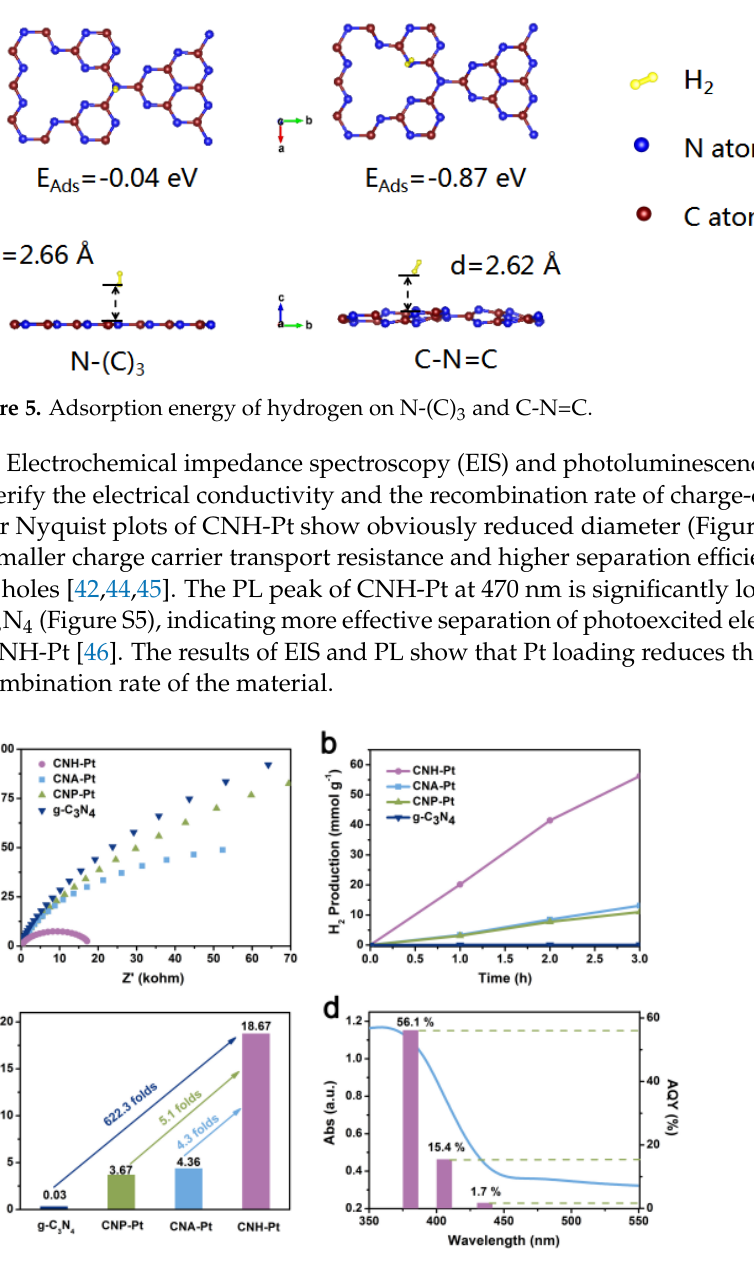
Figure 6. EIS Nyquist plots ( a ), time course of hydrogen evolution over 3 h ( b ) and hydrogen production rates ( c ) of CNH-Pt, CNA-Pt, CNP-Pt, and g-C 3 N 4 . ( d ) Wavelength-dependent AQY and absorption spectrum of CNH-Pt.